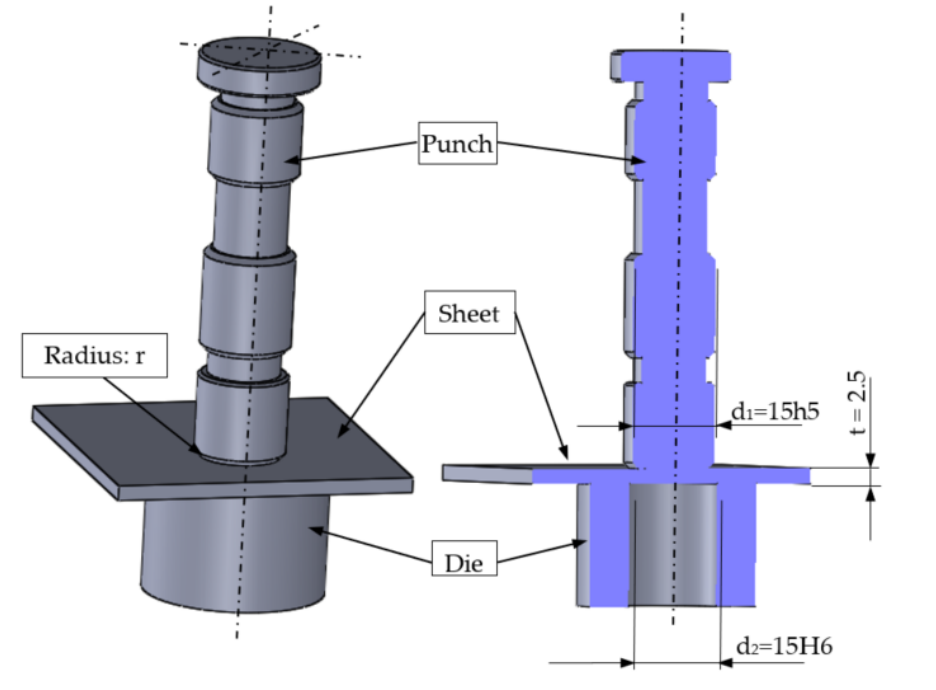
Figure 2. Nibbling equipment.